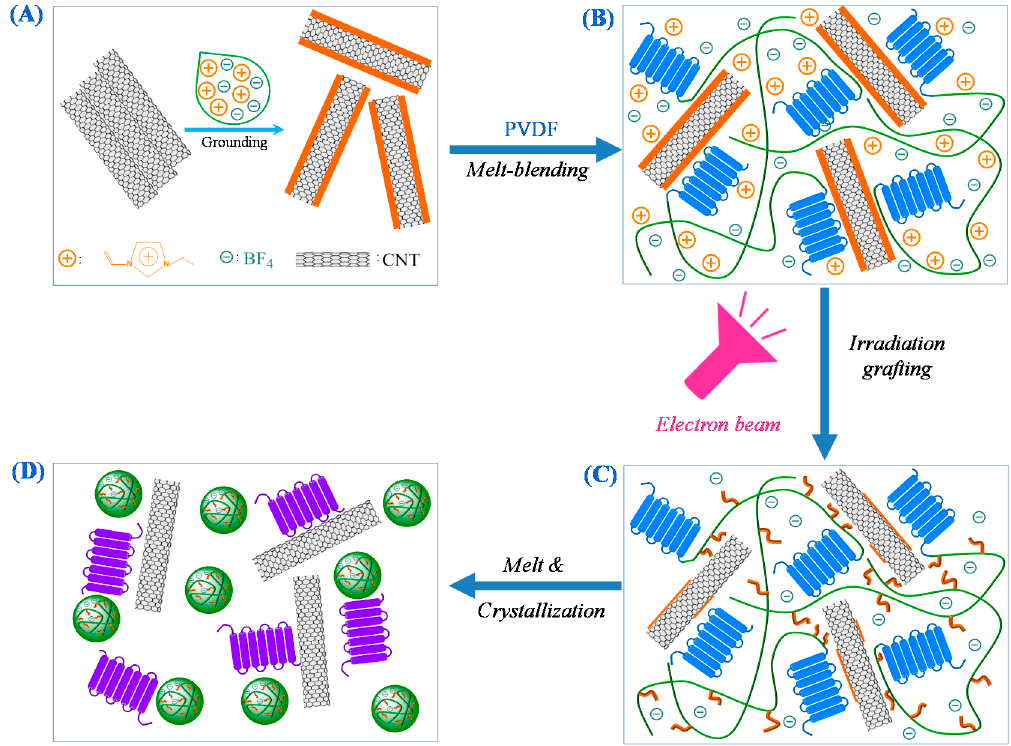
Figure 9. Schematic diagrams for the formation of ionic nanoclusters and CNTs structures in nano- PVDF/IL-CNTs composites. ( A ) First grounding of CNTs with IL resulted in IL-layer-coated CNTs; ( B ) melt-blending PVDF with such IL-layer-coated CNTs fabricated PVDF/IL-CNTs nanocomposites with homogeneously dispersed CNTs; ( C ) The PVDF/IL-CNTs nanocomposites then exposed upon electron beam irradiated (EBI) at room temperature in the air, whereas IL molecules in-suit grafted onto chains of PVDF; ( D ) the as-irradiated PVDF/IL-CNTs samples were heated to 210 ° C and held there for 30 min, and microphase separation of IL grafted PVDF (PVDF- g -IL) chains occurred in the melt. A following cooling procedure led to the nano-PVDF/IL-CNTs composites with PVDF- g -IL nanodomains (i.e. IL nanoclusters).